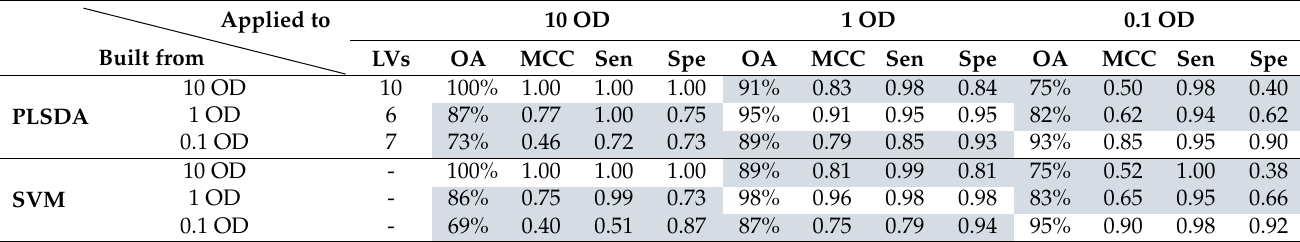
Table 7. Modelling performance of PLSDA and SVM classifiers built from one concentration and applied to other concentra- tions (deposited on STS) using 3500–2600 cm − 1 .